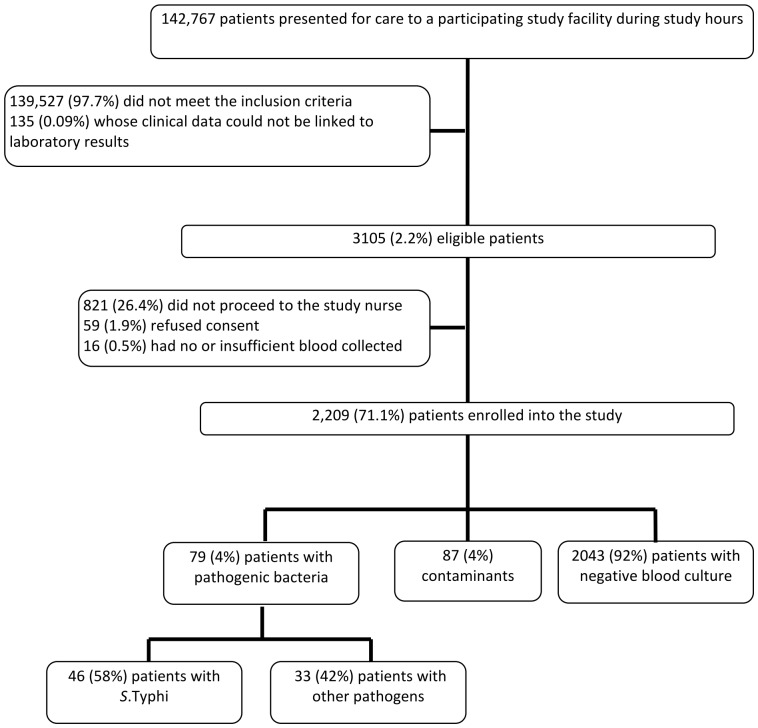
Consort chart of patients in the study.